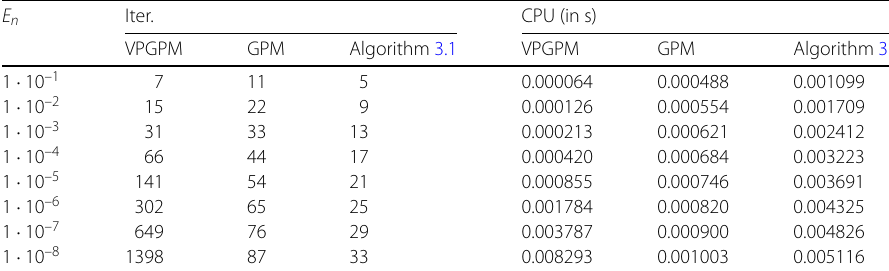
Table 1 Comparison of Algorithm 3.1 with GPM and VPGPM E n Iter. Algorithm 3.1 Algorithm